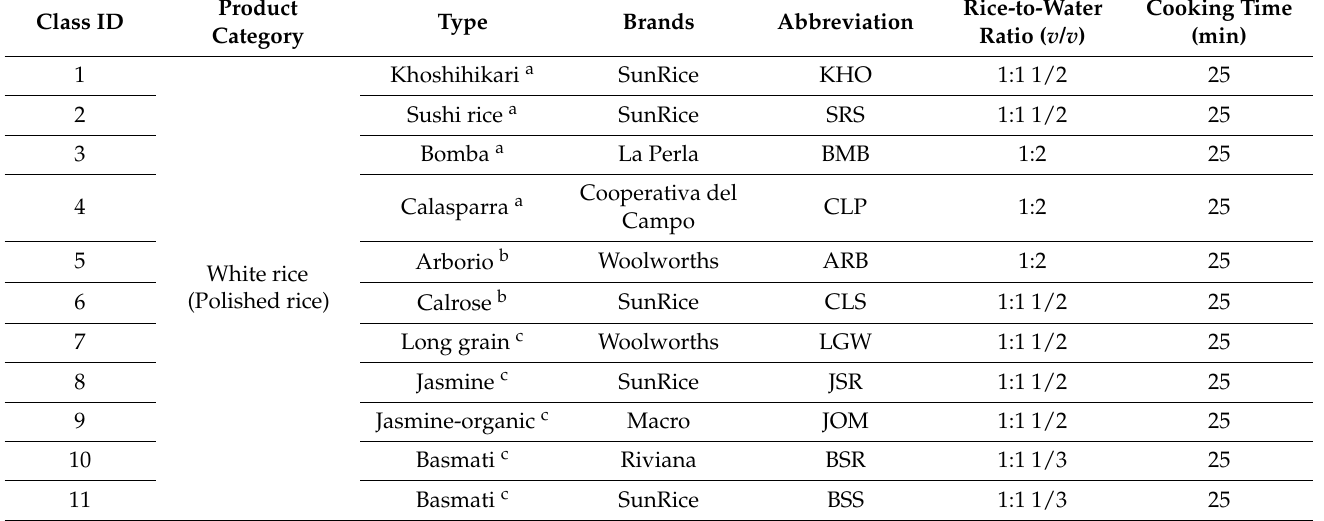
Table 1. Details of commercial rice samples used in the study, including class ID, product